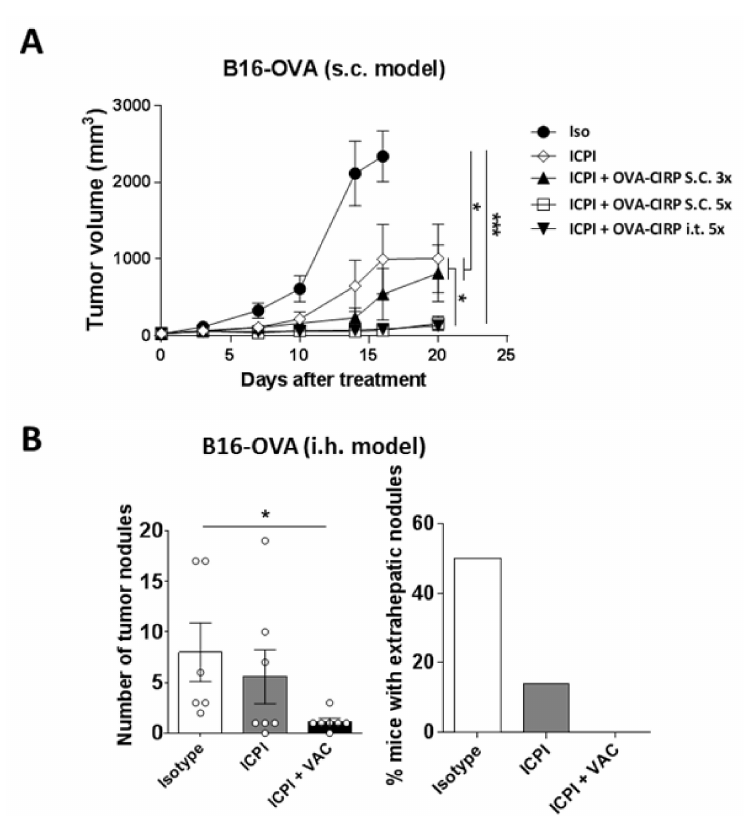
Figure 2. Immunization with OVA-CIRP enhances therapeutic responses induced by ICPI in subcutaneous and intrahepatic tumors. ( A ) C57BL6 / J mice ( n = 6 / group) bearing 5 mm subcutaneous B16-OVA tumors were treated with antibodies at days 0, 7, and 14 (Isotype, Iso; anti-CTLA-4 + anti-PD-1, ICPI) with or without OVA-CIRP vaccine administered subcutaneously or intratumor, 3 or 5 times. Tumor volume was measured twice / week. ( B ) B16-OVA cells were injected in the liver of C57BL6 / J mice and four days later they received control ( n = 6) or ICPI antibodies ( n = 7), or ICPI plus OVA-CIRP vaccine administered s.c. 5 times ( n = 7). Three weeks later livers were examined, analyzing the number of tumor hepatic nodules as well as the percentage of mice without extrahepatic tumor nodules. *, p < 0.05; ***, p <